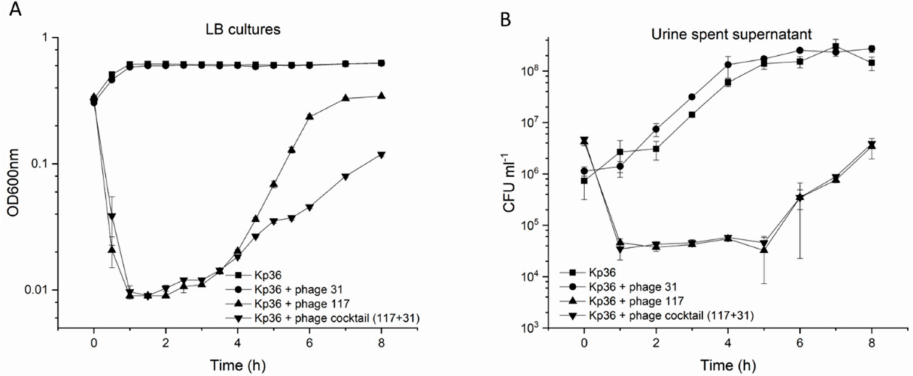
Figure 3. ( A ) Optical density (OD 600 ) in cultures of K. pneumoniae amended with phage 117 (black triangle), phage 31 (black circle), and phage cocktail (117 + 31, black inverted triangle) at MOIs of 0 (control, black square) and 0.1 were measured at 1-h intervals over an 8 h period of incubation in Luria Broth (LB). ( B ) Lytic potential of phage 117 (black triangle), phage 31 (black circle), and phage cocktail (117 + 31, black inverted triangle) on strain Kp36 and control without phages (black square) at MOIs of 0.1. Cell proliferation and viability were determined at 1-h intervals post 8 h of incubation in cell-free urine spent supernatant. The corresponding concentrations of bacteria in cultures (CFU / mL) were measured by colony forming units as described in Section 2. Error bars represent standard deviations from all experiments carried out in triplicates ( n =